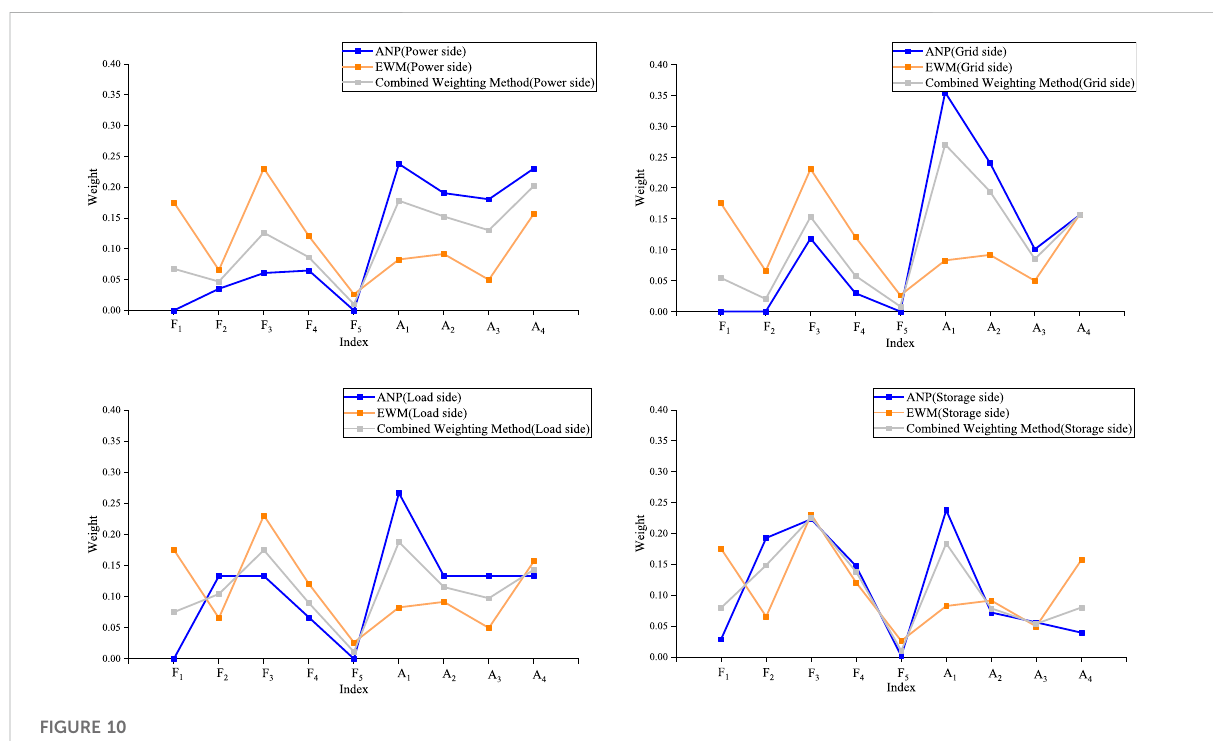
FIGURE 10 The weights calculated by different weighting methods in the complex